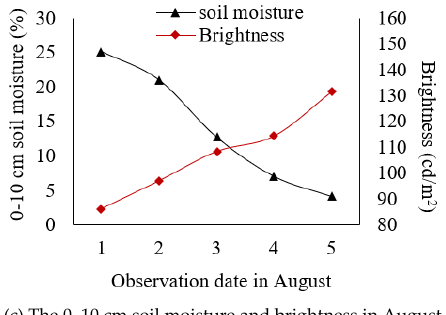
Figure 7. The 0–10 cm soil moisture and brightness.